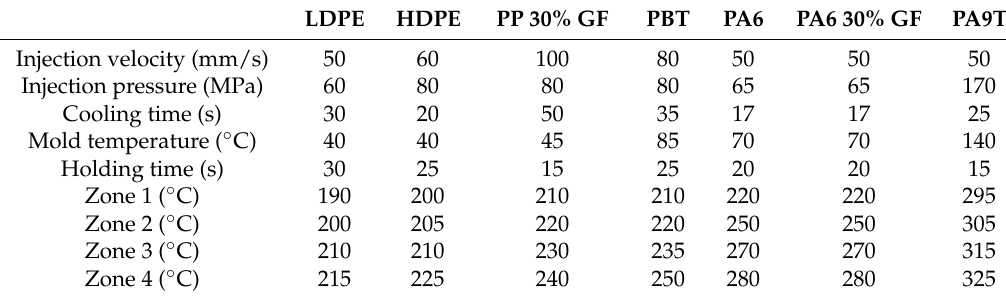
Table 2. Process